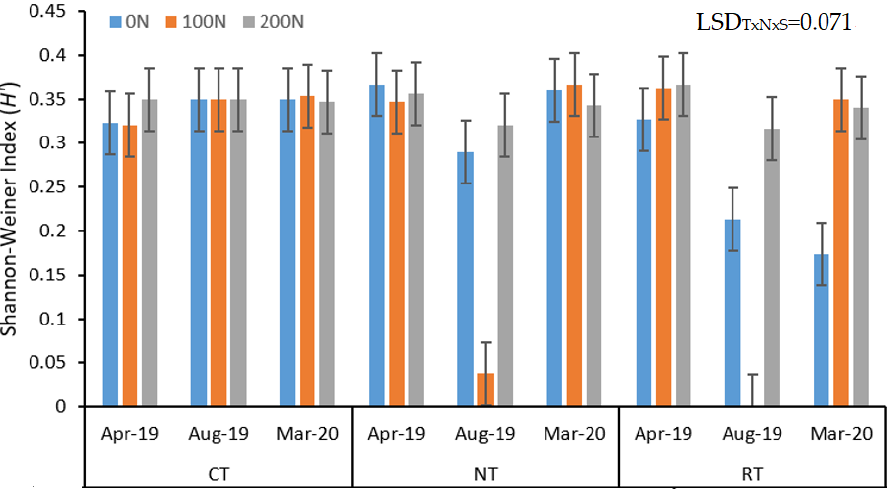
Figure 8. Variation in the Shannon – Weiner index of soil macrofauna communities relative to tillage treatments, N fertiliser application rates, and sampling times. April-19 = April 2019, Aug-19 = August 2019 and Mar-20 = March 2020. T = treatments, N = nitrogen fertiliser application rate and S = sampling time.